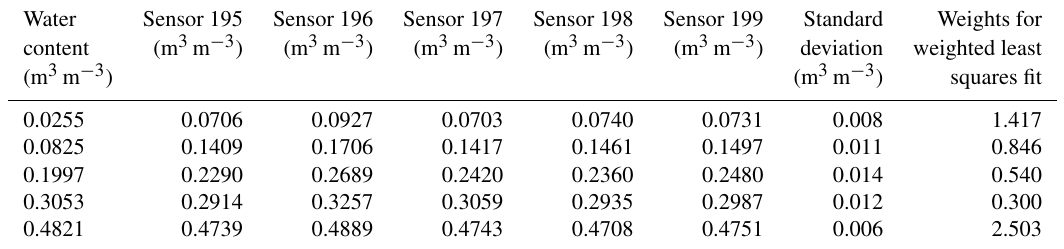
Table A2. Gravimetric soil water content (first column), soil water content measured with FP sensors (columns two to six), standard